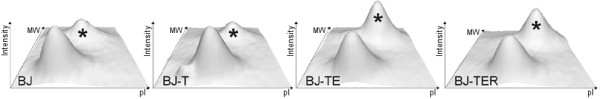
3D view of a gel section from all cell lines: TRAP-1 (spot 32) is identified in the spot marked with an asterisk. Representative single gel sections are selected, that is, those sections closest to the mean of all five gels from one cell line.